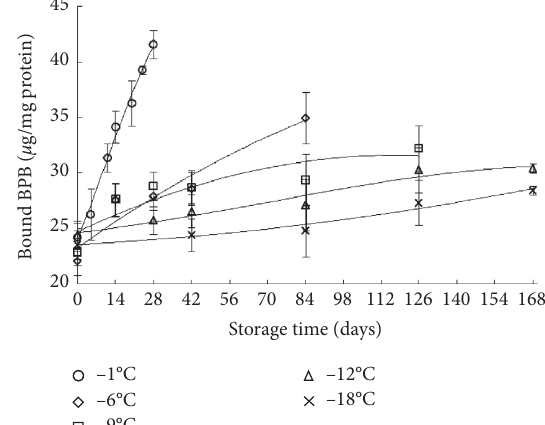
Figure 4: Changes in the surface hydrophobicity of beef MP during storage at − 1, − 6, − 9, − 12, and − 18 °